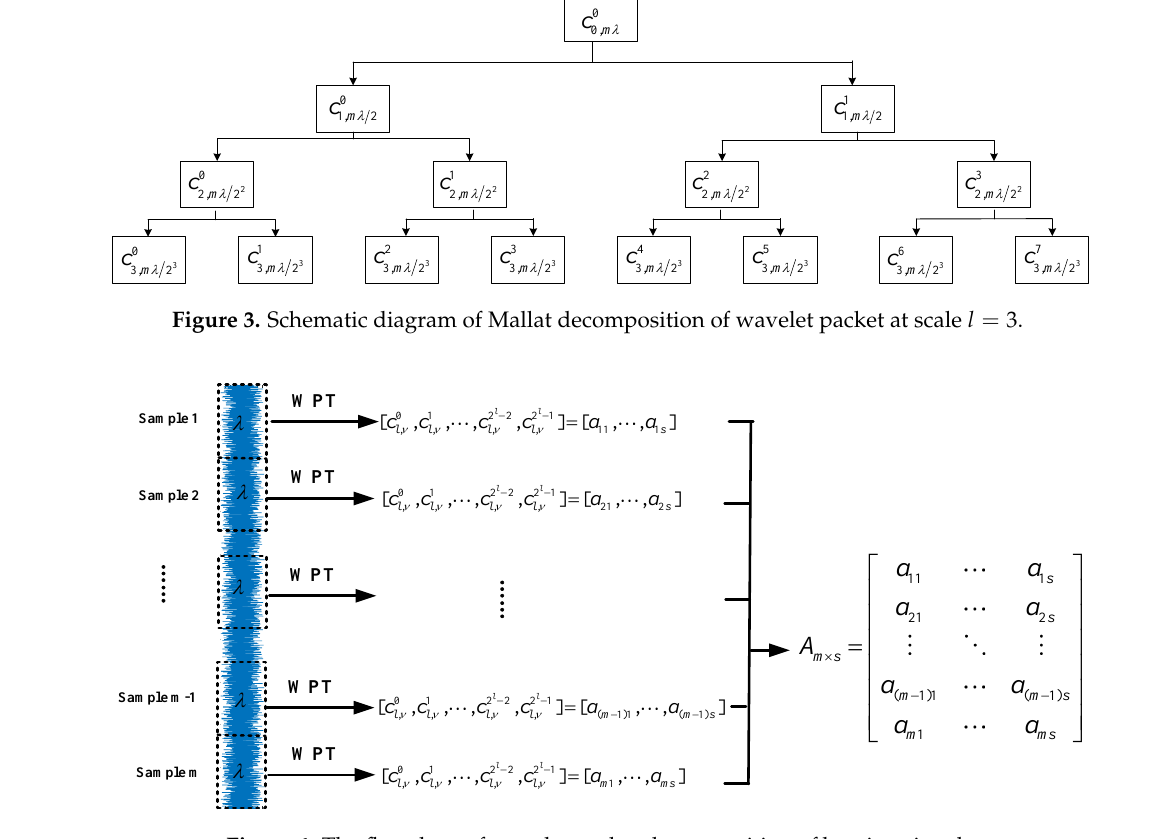
Figure 4. The flowchart of wavelet packet decomposition of bearing